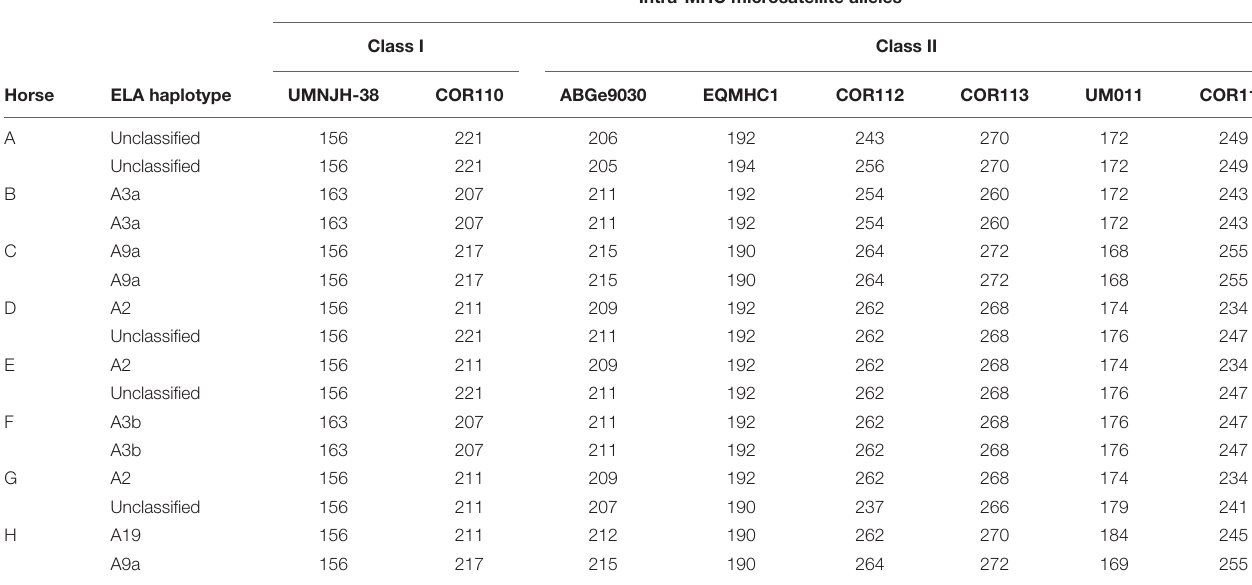
Intra-MHC microsatellite